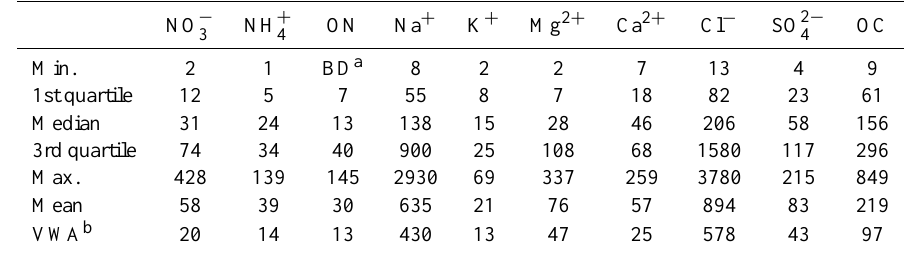
Table 1. Statistical summary of concentrations of dissolved chemical species in precipitation analyzed in this study (unit: µmolL − 1 ).